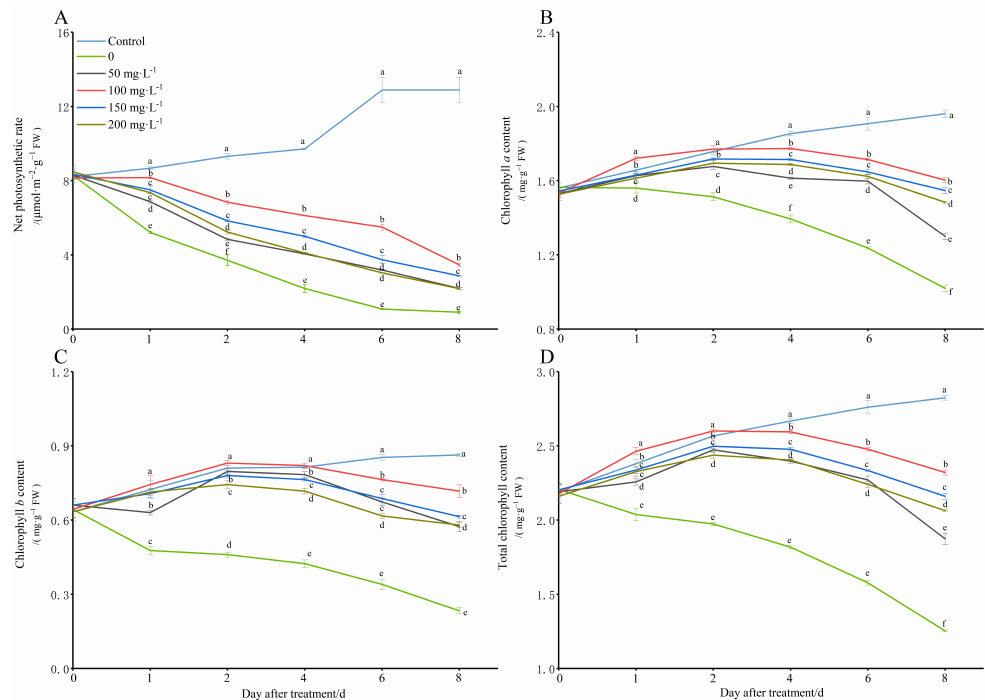
Figure 3. Change in net photosynthesis rate and chlorophyll a , chlorophyll b and total chlorophyll content with exogenous chitooligosaccharides under low-temperature conditions (8 ◦ C). On each subgraph, different letters in the same column indicate significant differences in the p < 0.05 level. Data in the figure are presented as the mean ± standard deviation (n =